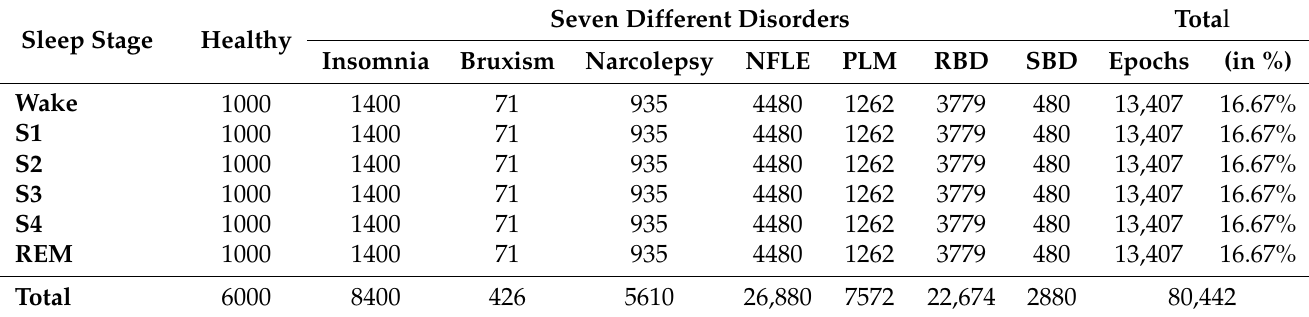
Table 4. Sleep stage-wise and subject-wise details of epoch distribution in the created balanced data. Sleep Stage